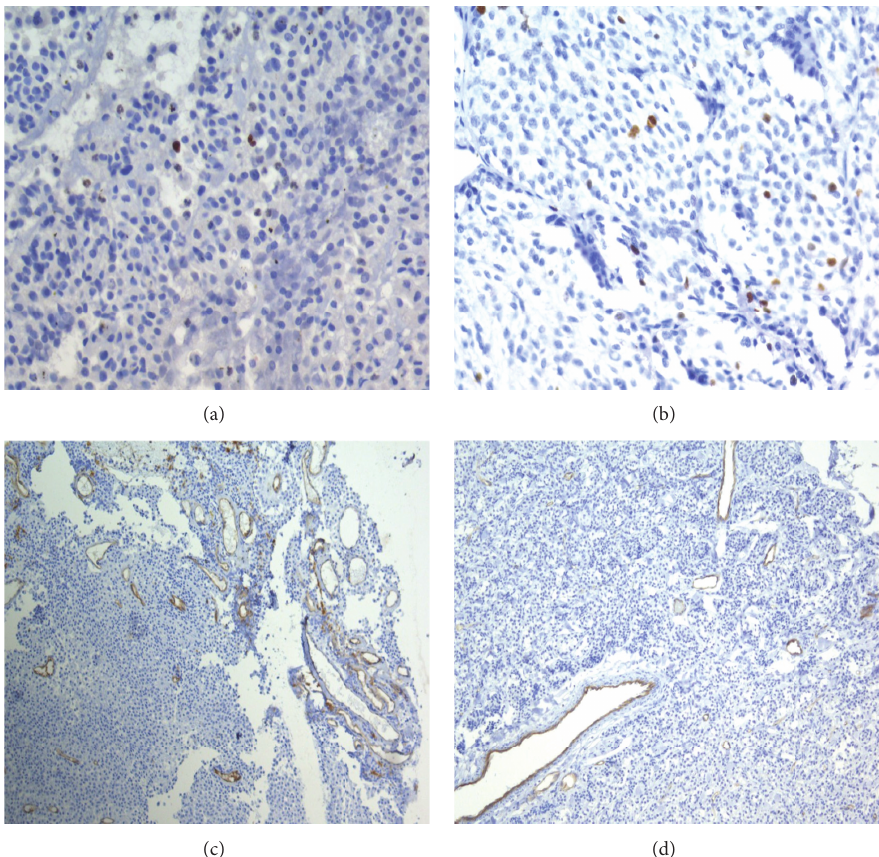
Figure 6: Expression of Ki-67, CD31 in corticotropinomas and ectopic ACTH-secreting tumours. (a) Indirect anti-Ki-67 immunoperoxidase staining of corticotropinoma cell nuclei, × 40. (b) Indirect anti-Ki-67 immunoperoxidase staining of the cell nuclei in atypical lung carcinoid, × 40. (c) Indirect anti-CD31 immunoperoxidase staining of vascular endothelium in corticotropinomas, × 10. (d) Indirect anti-CD31 immunoperoxidase staining of vascular endothelium in typical lung carcinoid, ×